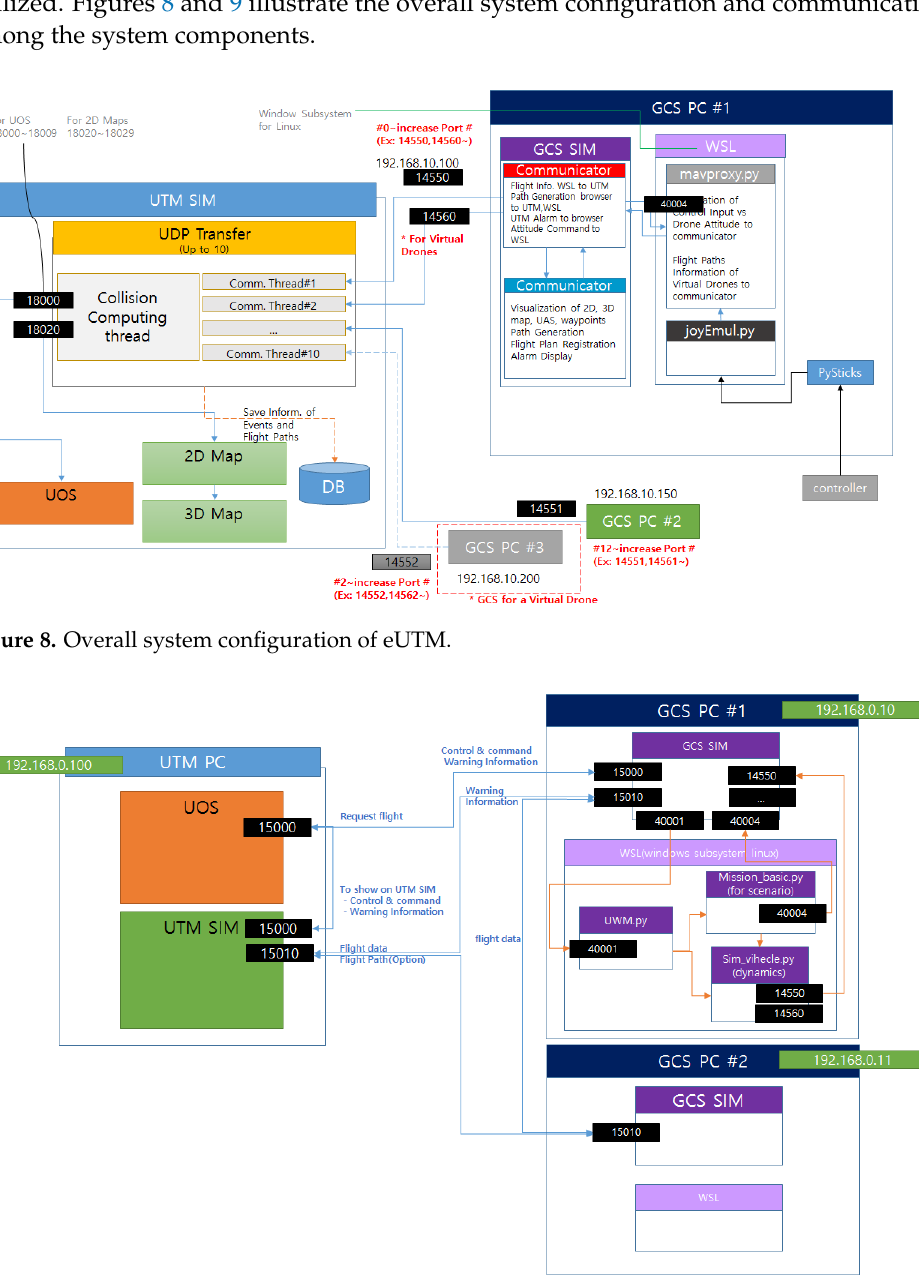
Figure 9. Communication among UOS, UTM, and